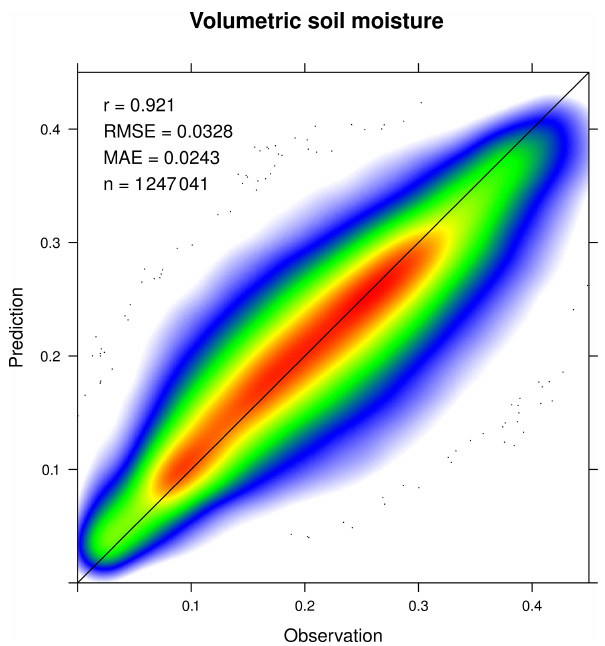
Figure 2. Comparison of observed and predicted volumetric surface soil moisture considering all daily grid cell values available globally during the years 2014 and 2015. The colours represent the density distribution of the scatter, and outliers are represented by dots. Pear- son correlation coefficient r , root-mean-square error (RMSE), mean absolute error (MAE) and the number of data points n are provided in the upper-left